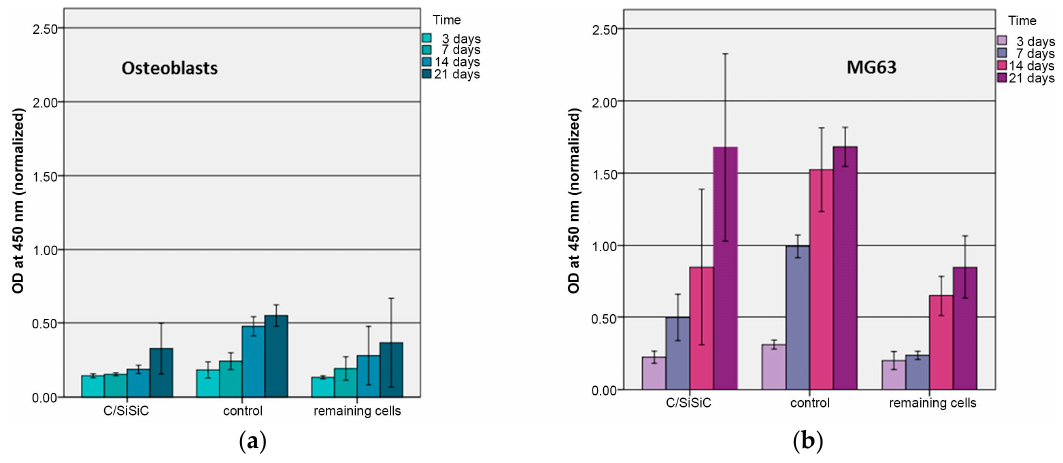
Figure 6. WST assay to demonstrate proliferation of human osteoblasts ( a ) and MG 63 ( b ) on the samples. C/SiSiC-cells on the composite after removing it out of the cell culture plate; control-cells only, remaining cells-cells remaining in the same cell culture plates, which were moving from the top of the composite and settled at the walls of the cell culture plate, all values were normalized to 1 cm².